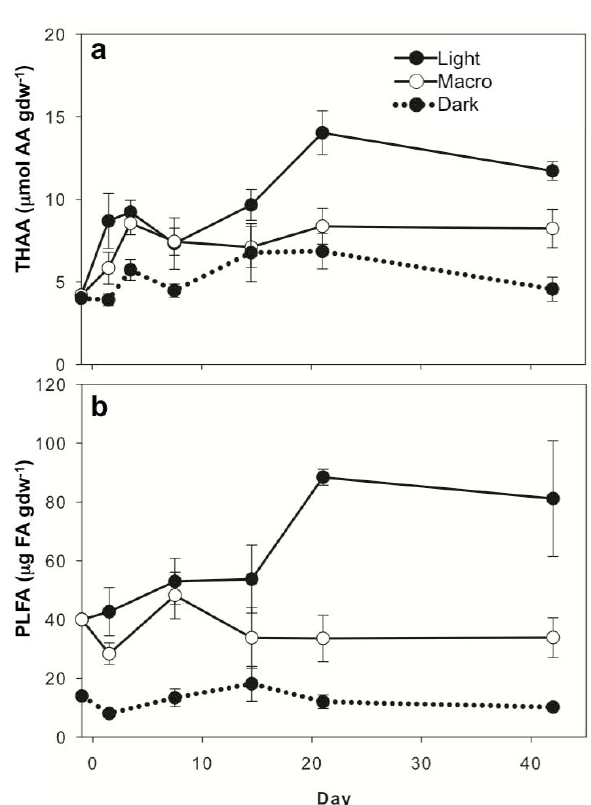
Fig. 3. THAA (a) and total PLFA (b) concentrations in surface (0– 1cm) sediments. Values are mean ± SE ( n =